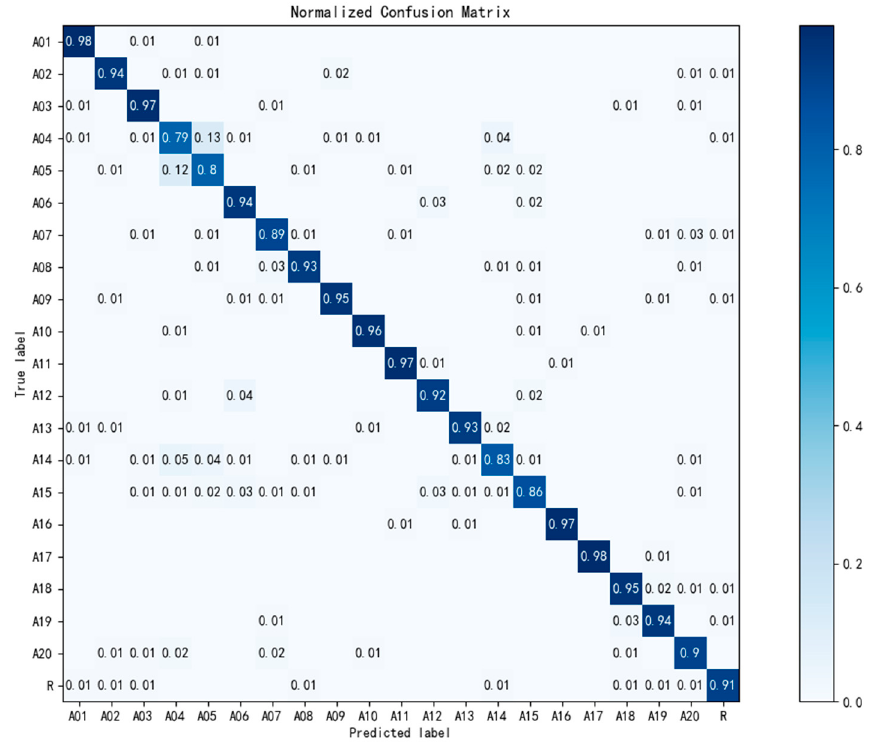
Figure 8. Hybrid test confusion matrix of all subjects.